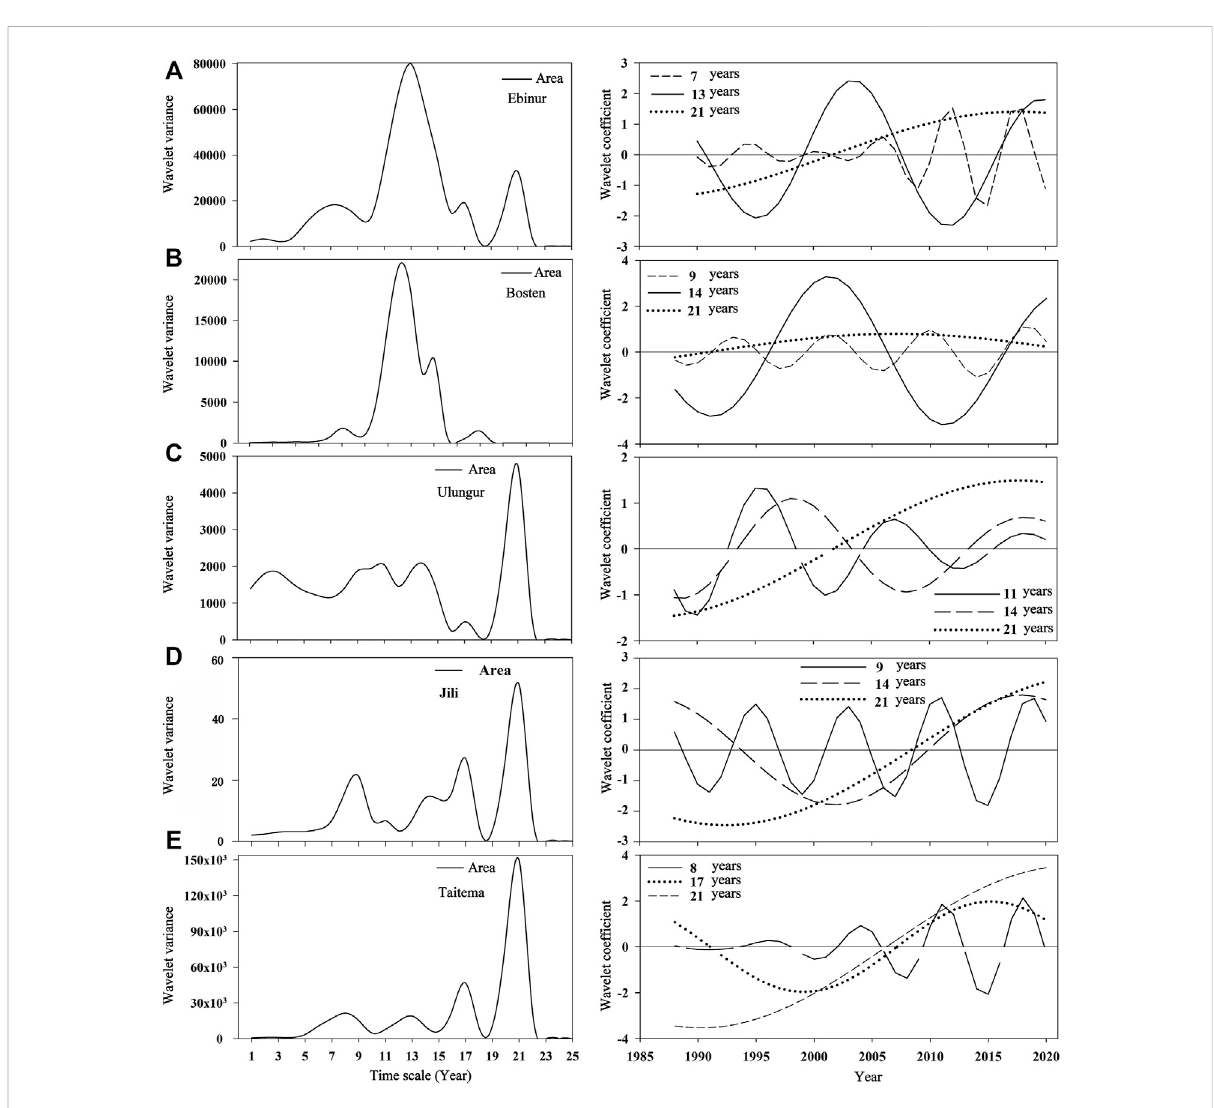
FIGURE 6 ResultsofwaveletanalysisoftypicalplainslakesareainXinjiangfrom1986to2020 (A) LakeEbinure; (B) LakeBosten; (C) LakeUlungur; (D) Lake Jili; (E) Lake